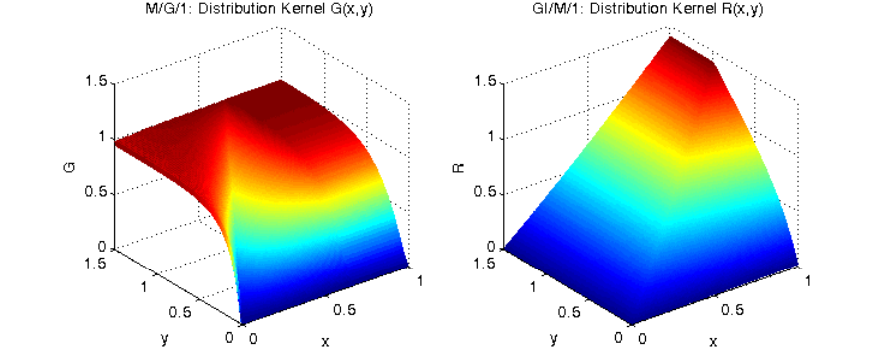
Figure 5. Numerical solutions of kernel functions. The right picture is about the kernel R ( x , y ) , and the left is about its dual kernel G ( x , y )